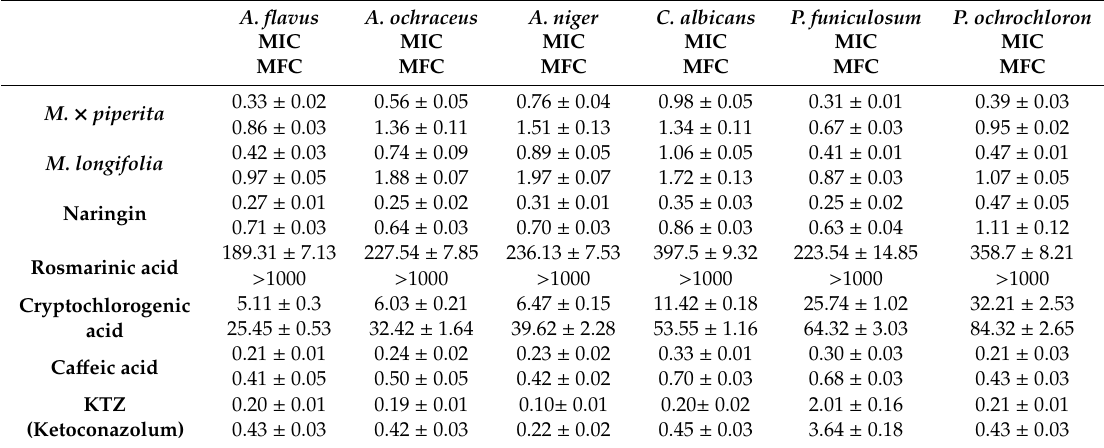
Table 5. Minimum inhibitory (MIC) and fungicidal concentrations (MFC) of M. × piperita and M. longifolia leaf extracts, naringin, and rosmarinic, cryptochlorogenic and ca ff eic acids. Values are presented as the mean ± SD of three replicates ( µ g /